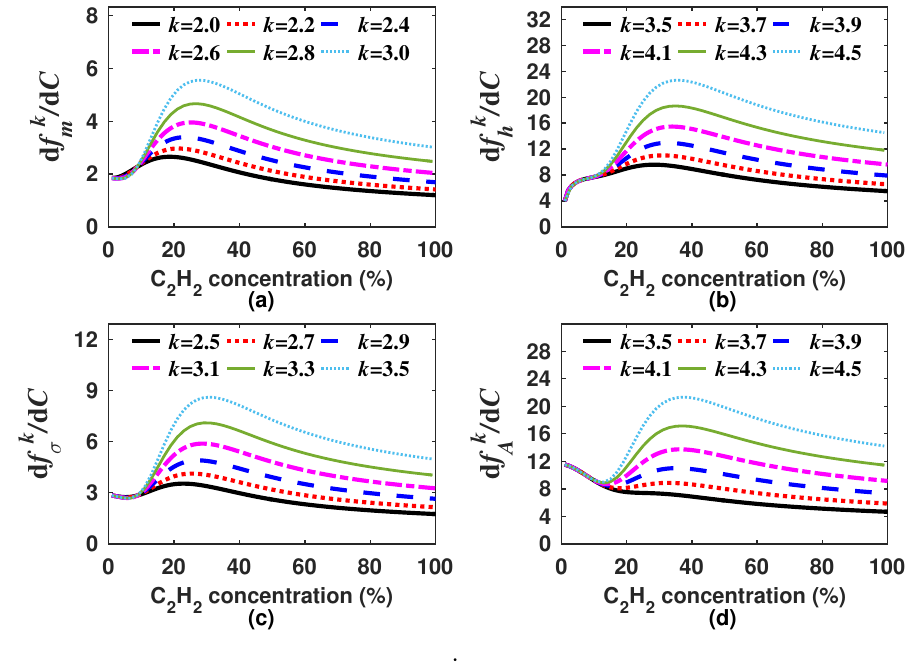
Figure 8. Sensitivities of the generating functions ( a ) f k m ; ( b ) f k concentration for an interval of k values that generate functions with a quasi linear